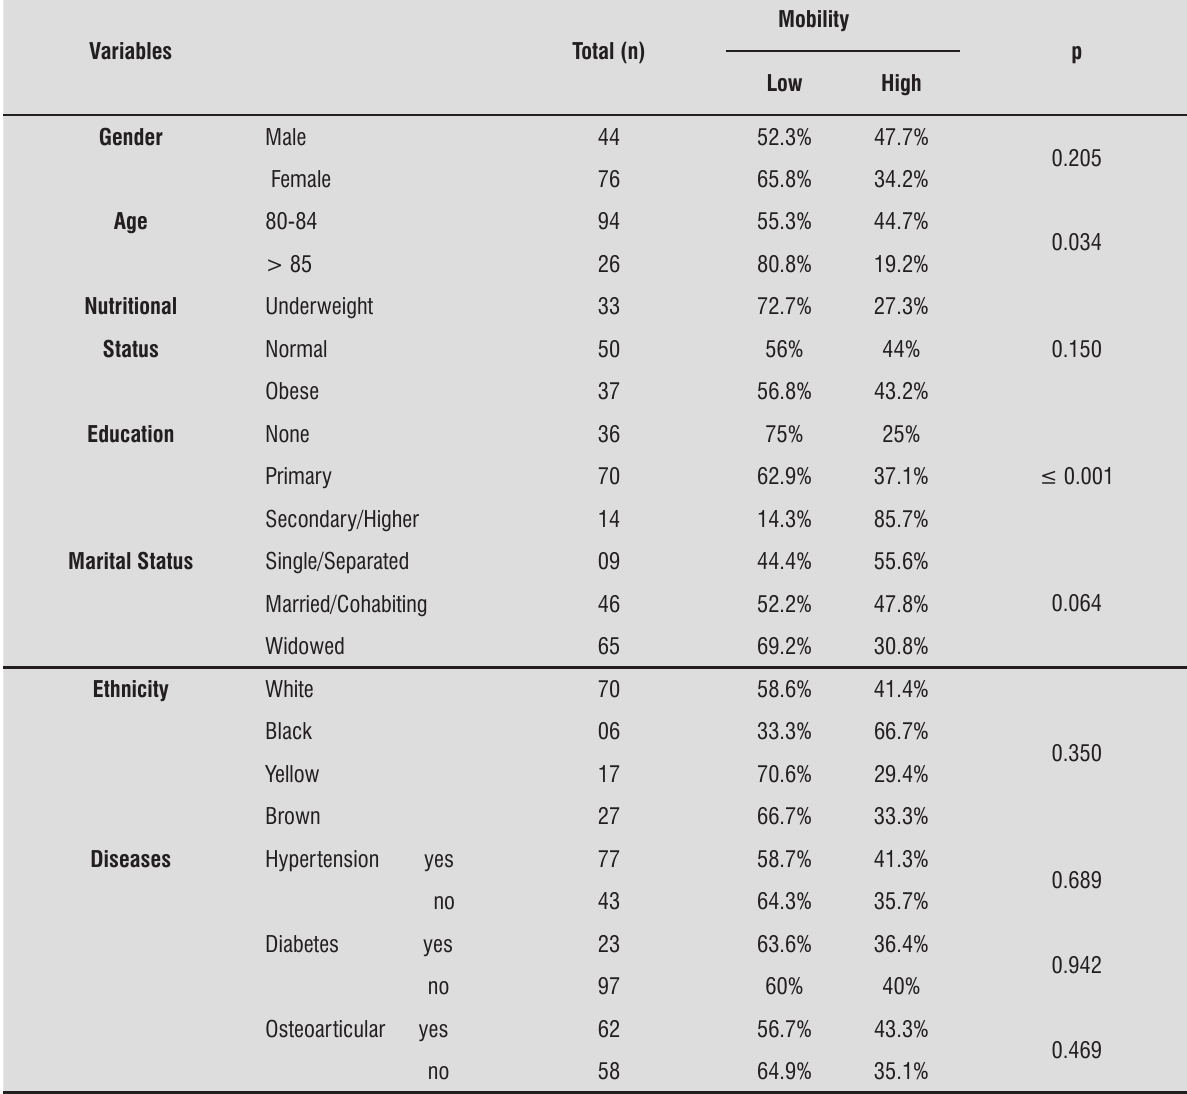
Table 1 - Relationship between sociodemographic factors, NCDs and mobility of the oldest old